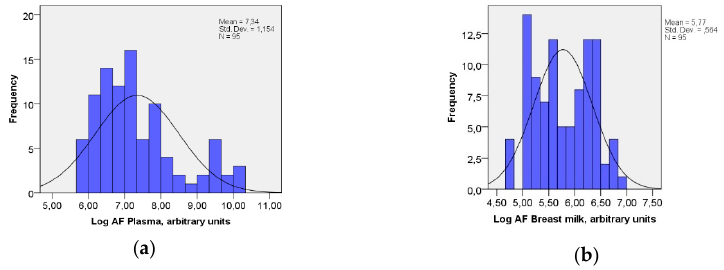
Figure 1. ( a ) Distribution of log AF-levels (arbitrary units) in the plasma Kolmogorov–Smirnov test of normality, p < 0.05. ( b ) Distribution of log AF-levels (arbitrary units) in breastmilk. Kolmogorov–Smirnov test of normality, p < 0.05.